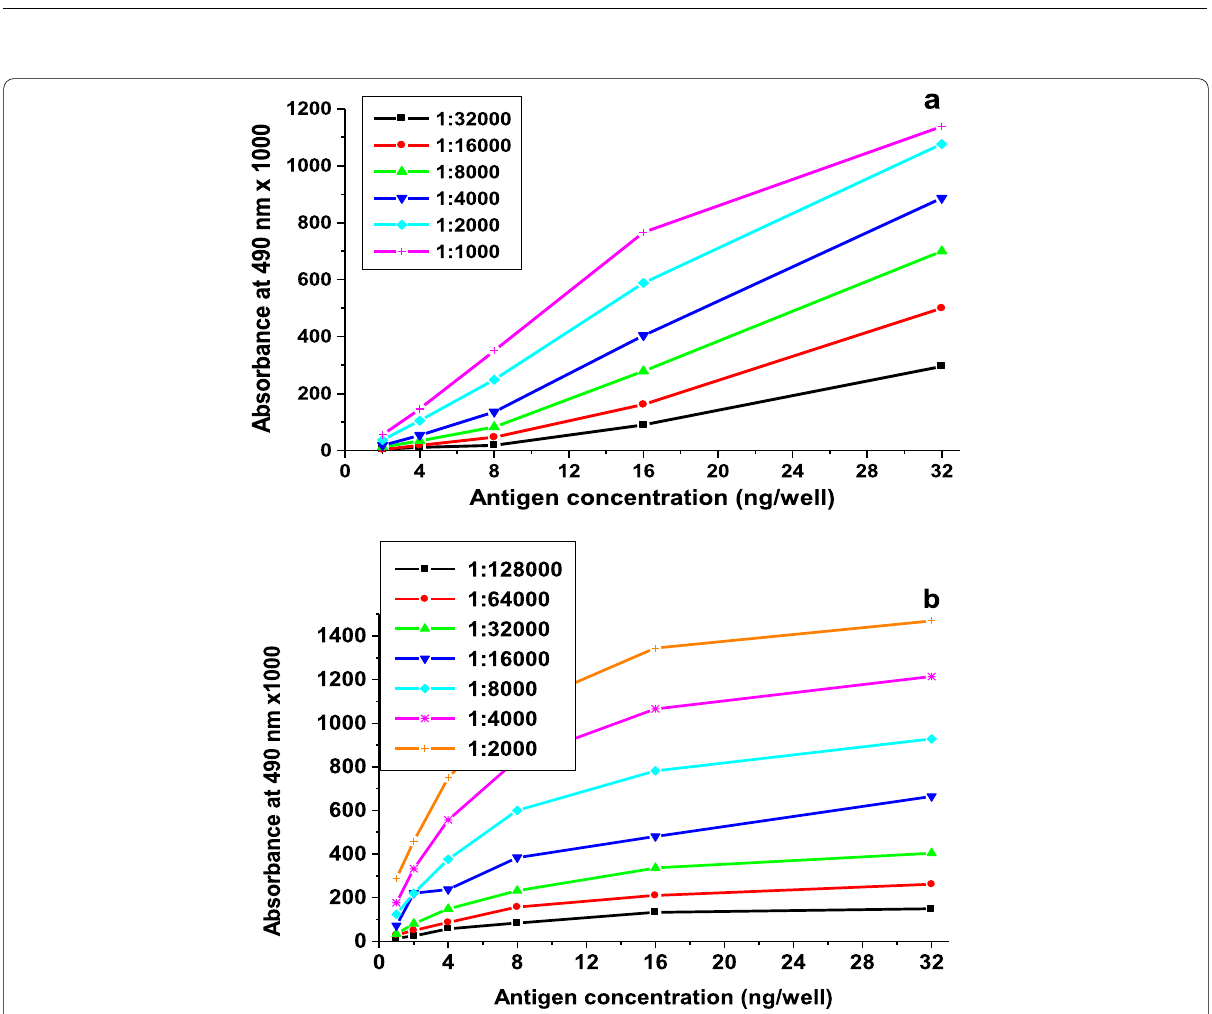
Fig. 3 Determination of the optimal concentrations of the antigen and antibodies used in ELISA test. The micro‑titer plate was sensitized with different concentrations of BaGST2 or BaGST3 starting from 640 ng/mL and ending with 20 ng/mL. The serial dilution of anti‑BAGST2 polyclonal antibodies used was from 1:1000 to 1:32000 ( a ) and that for anti‑BaGST3 was from 1:2000 to 1:128000 ( b